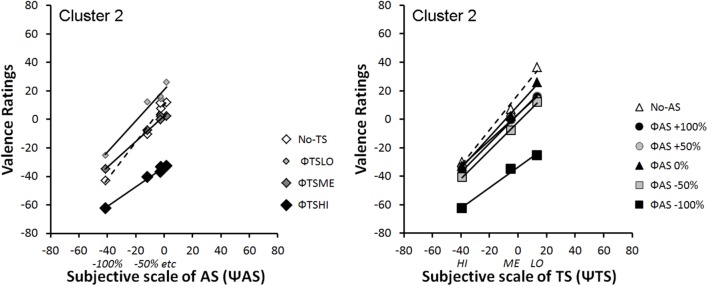
Mean integration graphs of Cluster 2 participants as a function of their subjective (Ψ) scaling for each stimulus category.